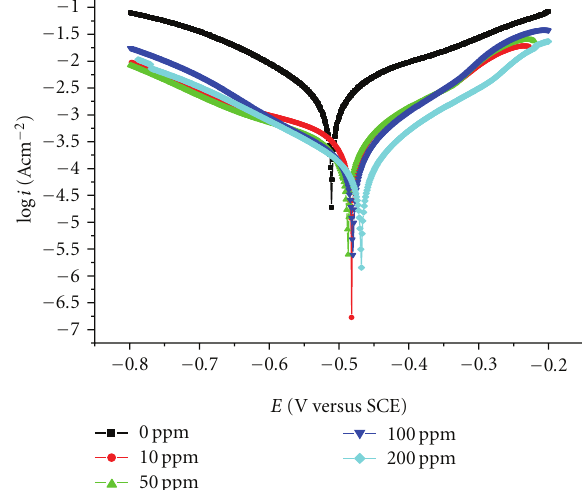
Figure 2: Potentiodynamic polarization curves of mild steel in 1M HCl solution at 30 ◦ C containing various concentrations of in-